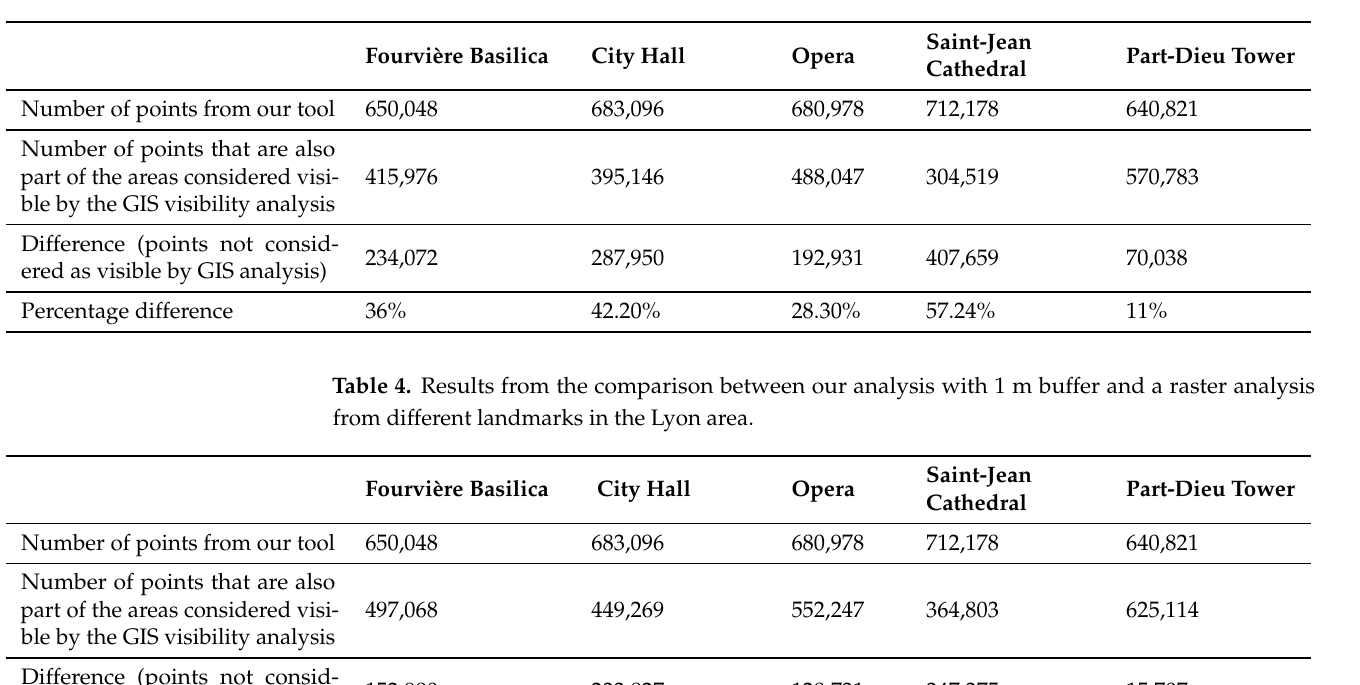
Table 3. Results from the gross comparison between our analysis and a raster analysis from different landmarks in the Lyon area.